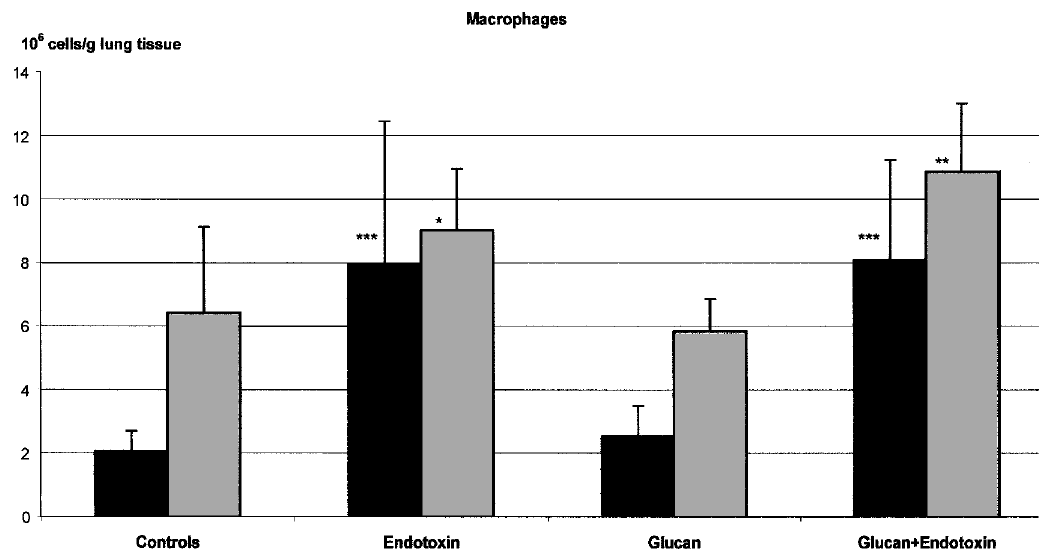
FIG. 1. The numbers of macrophages in lung lavage fluid (black bars) and lung interstitium (grey bars). The results are presented as mean values with standard deviations. * p < 0.05, ** p < 0.01, *** p < 0.001 as compared to controls.